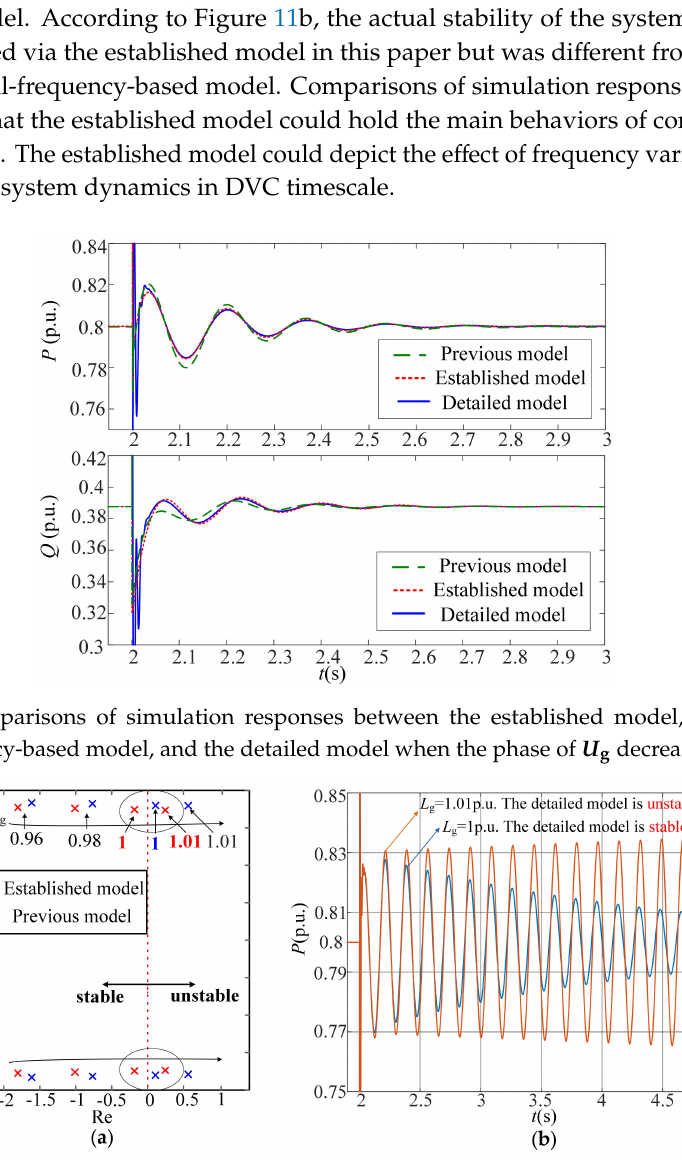
Figure 11. ( a ) Comparisons of dominant eigenvalue locus between the established model and the previousmodelatdi ff erentgridstrengths. ( b )Responses ofactivepoweroutput P forthe